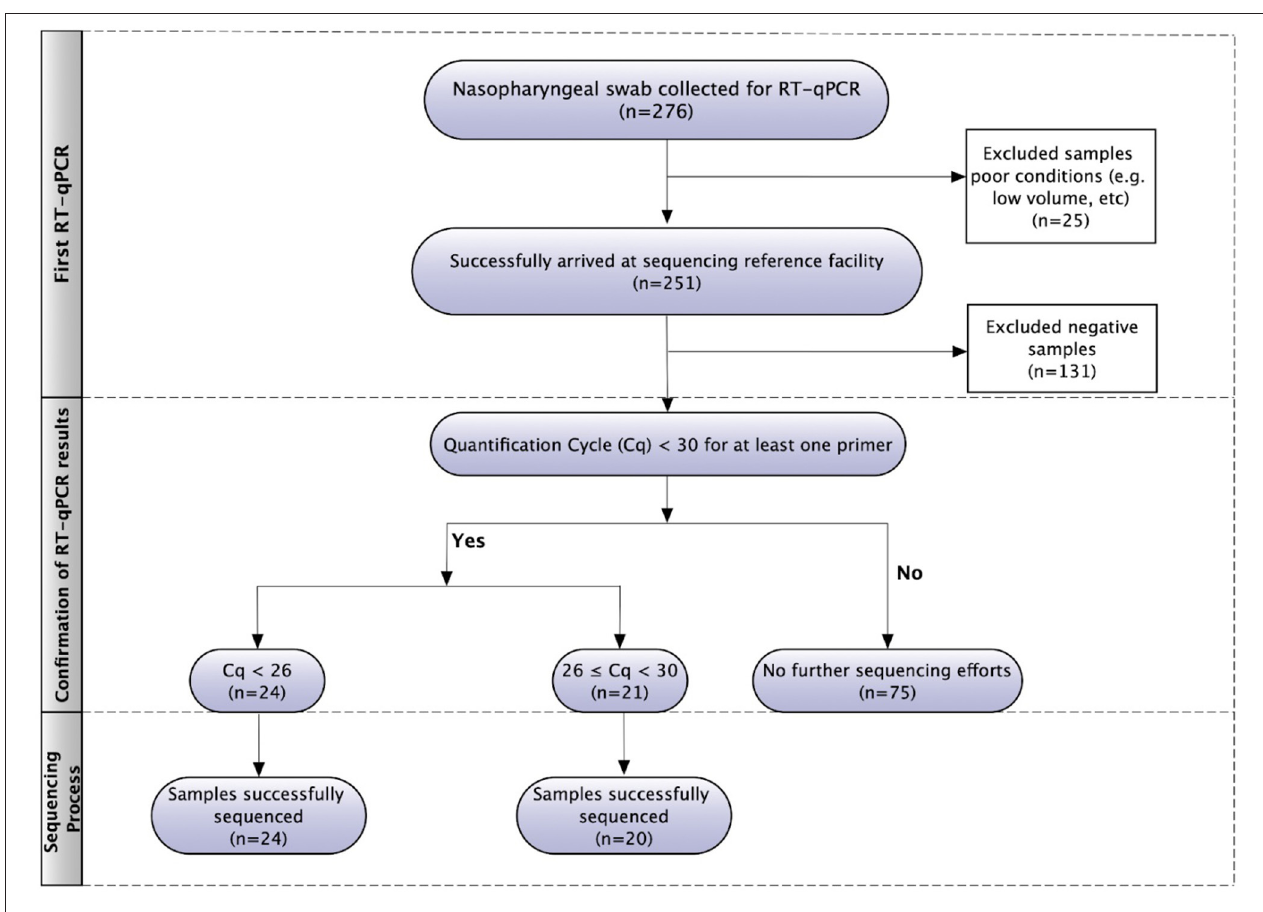
FIGURE 1 | Flowchart of SARS-CoV-2 RT-qPCR and genome